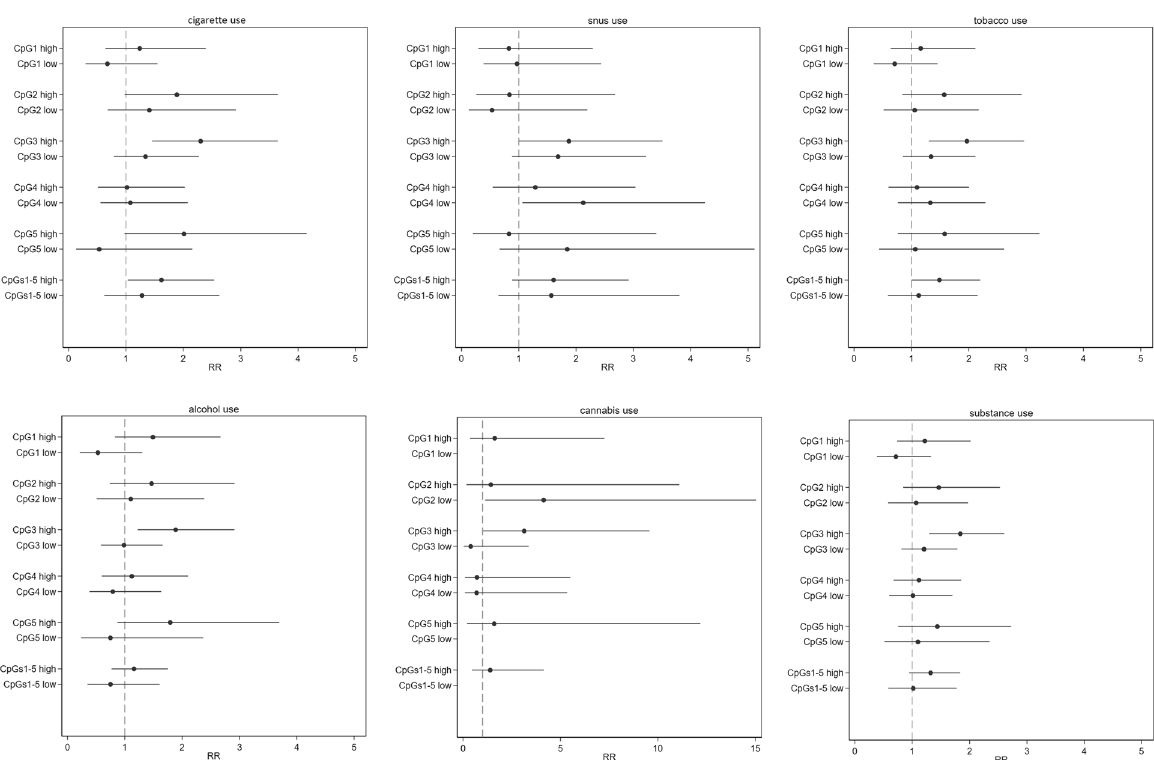
Fig. 2 Bi-variate association between NR3C1 methylation at baseline and self-reports of recent use assessed over 3 years. The results should be interpreted in terms of rate ratios (RRs) with 1 as a null value. Methylation level 0% was considered as the reference category. Low methylation group: methylation levels below the median of detectable methylation and high methylation group: methylation levels above the median. RRs were not estimated for the CpG1 CpG5 and CpG1 – 5 sites with low methylation for cannabis use given no cases in these groups. The cases/total are available in Table S2.